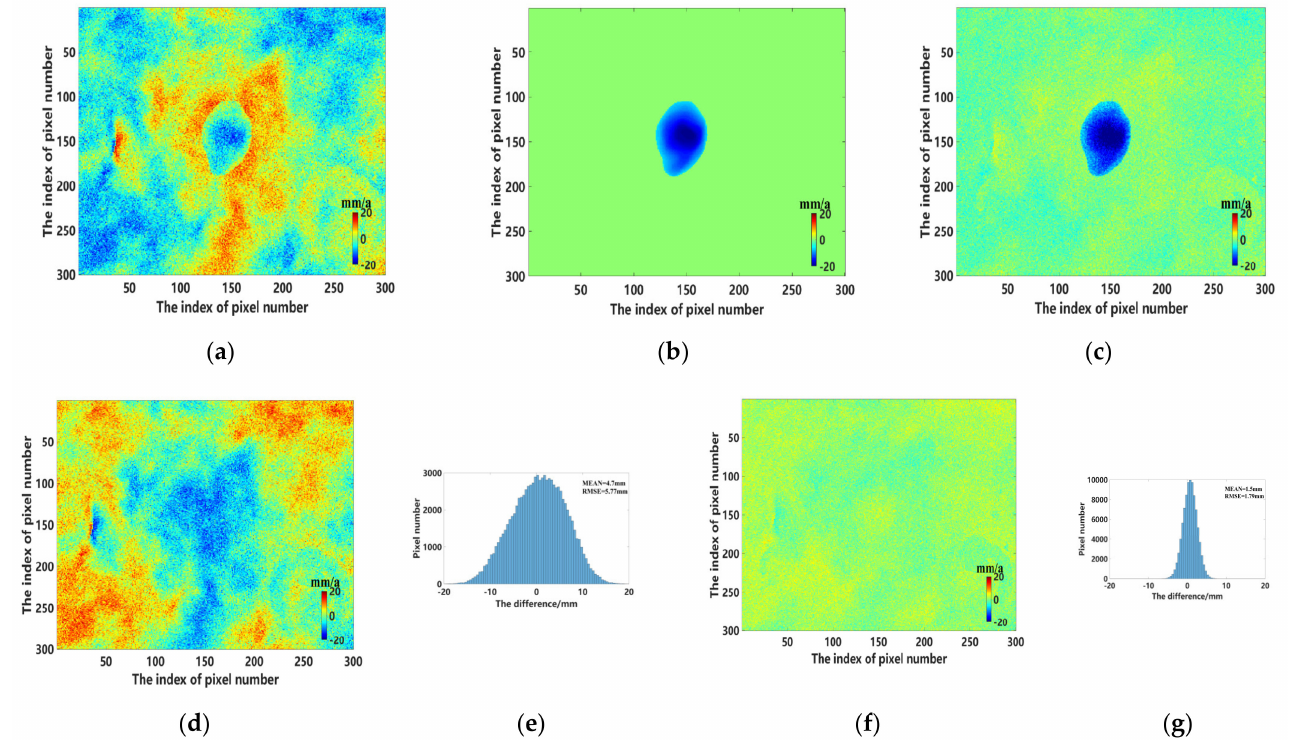
Figure 6. The annual deformation rate based on ( a ) the spatio–temporal baseline threshold method ( b ) the manual method ( c ) the ResNet50–DCNN method. ( d ) Difference between ( a , b ). ( e ) Histogram of ( d ). ( f ) Differences between ( a , c ). ( g ) Histogram of ( f